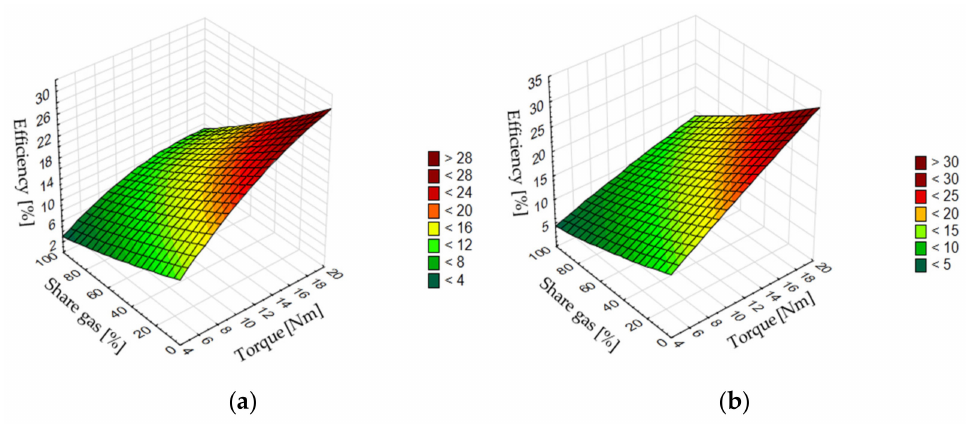
Figure 12. Efficiency of the cogeneration unit for the mixtures: ( a ) DF + CNG and ( b ) RME +